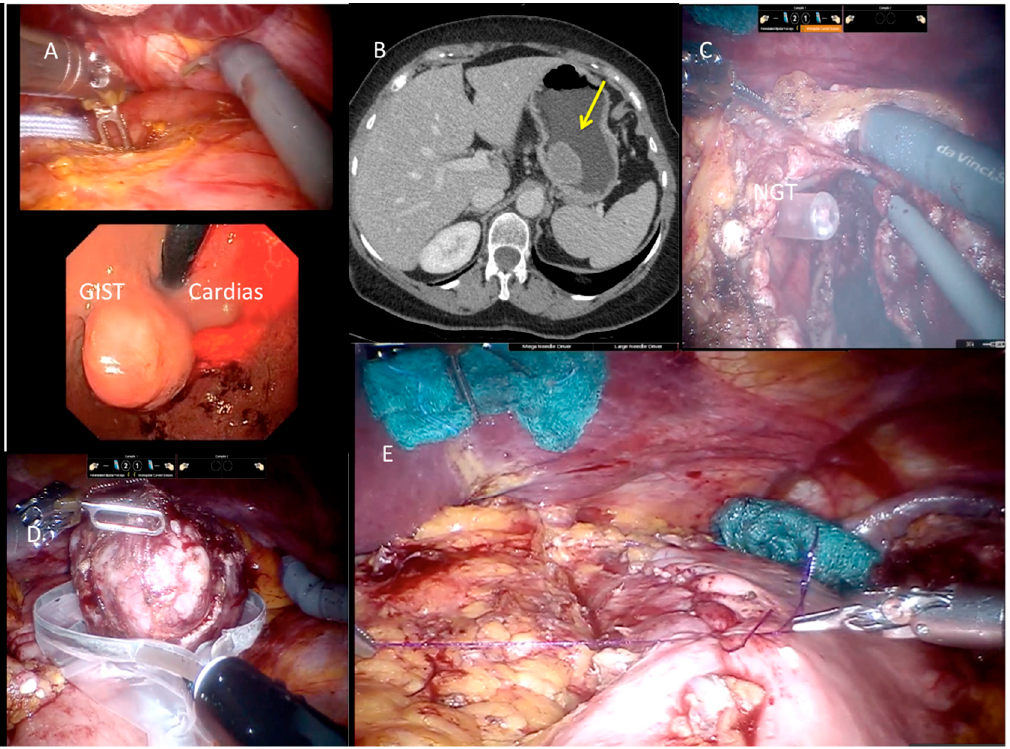
Figure 5. Lesion in CT, endoscopy, and GIST resection.